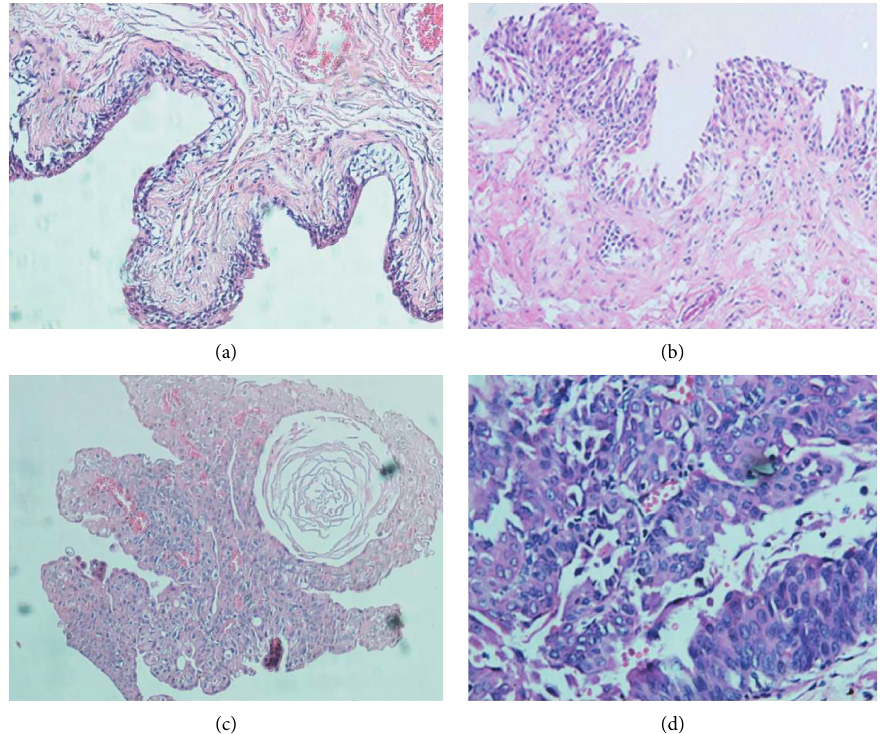
Figure 2: Histopathological specimen examination of the rat bladder of the control (a), 15th week (b), 25th week (c), and 35th week (d). Note. (a) The epithelial tissue was composed of 2–3 layers, and the cells were extremely obvious, without abnormality, and arranged in an orderly manner. (b)There were papillary hyperplasia in the partial region, the epithelial cell had 4–6 layers, polarity had a little disorder, and